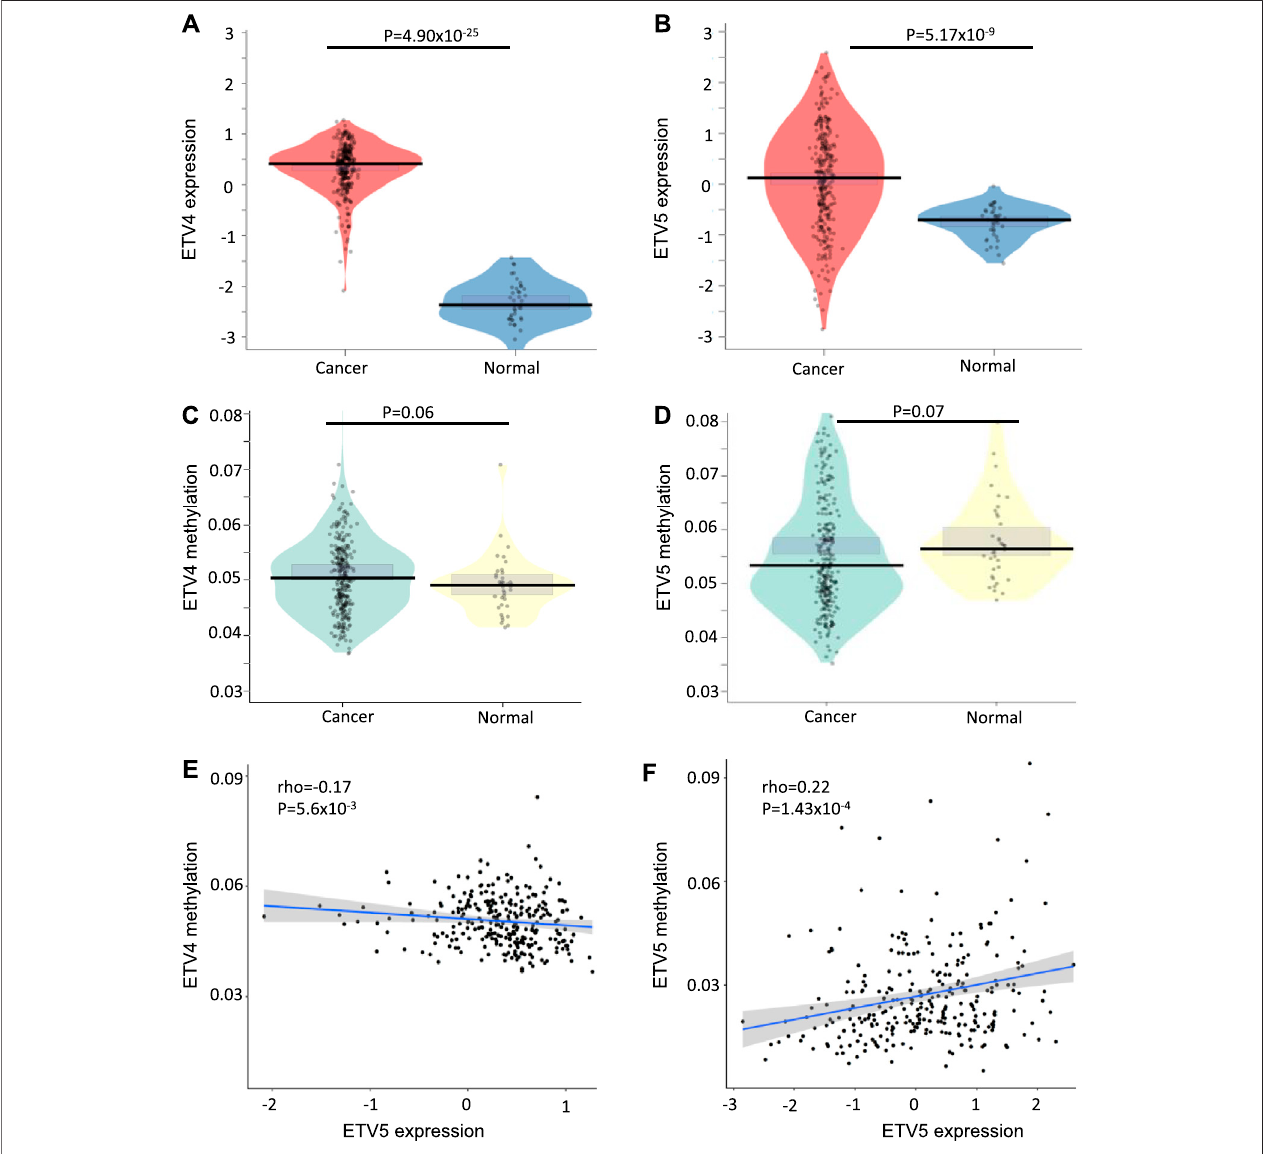
FIGURE 1 | DNA methylation regulates ETV4 and ETV5 expression in colon cancer. ETV4 (A) and ETV5 (B) are overexpressed in cancerous tissue compared to healthy tissue in TCGA samples. Violin plot showing promoter methylation difference between cancer and normal tissue for ETV4 (C) and ETV5 (D) genes. The p -value has been calculated using the Wilcoxon nonparametric test. Scatterplot showing spearman ’ s correlation between promoter methylation and expression levels of ETV4 (E) andETV5 (F) inthecanceroustissueoftheCCpatientsfromTCGAdata.TheSpearmancorrelationcoef fi cientandrespective p -valueshavebeenshown in the fi